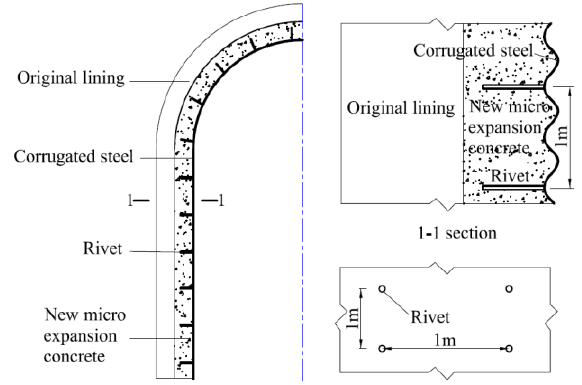
Figure 3. Corrugated steel plate reinforcement method.